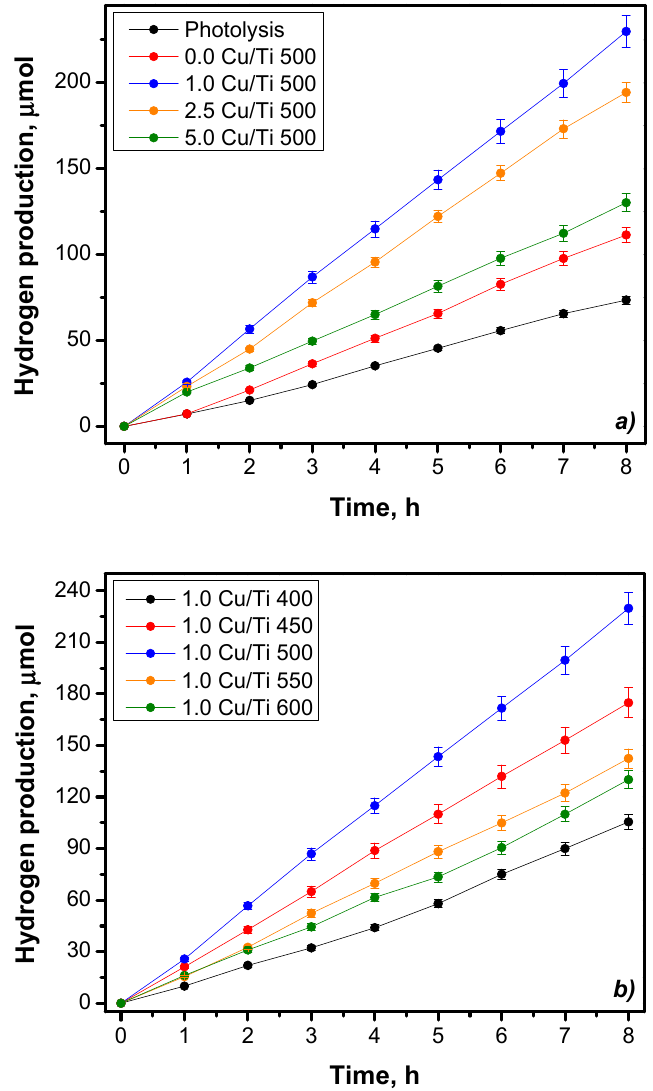
Figure 7. Photocatalytic evaluation during the water-splitting reaction of the ( a ) X Cu/Ti 500 mate- rials, and ( b ) 1.0 Cu/Ti calcined at different temperatures.